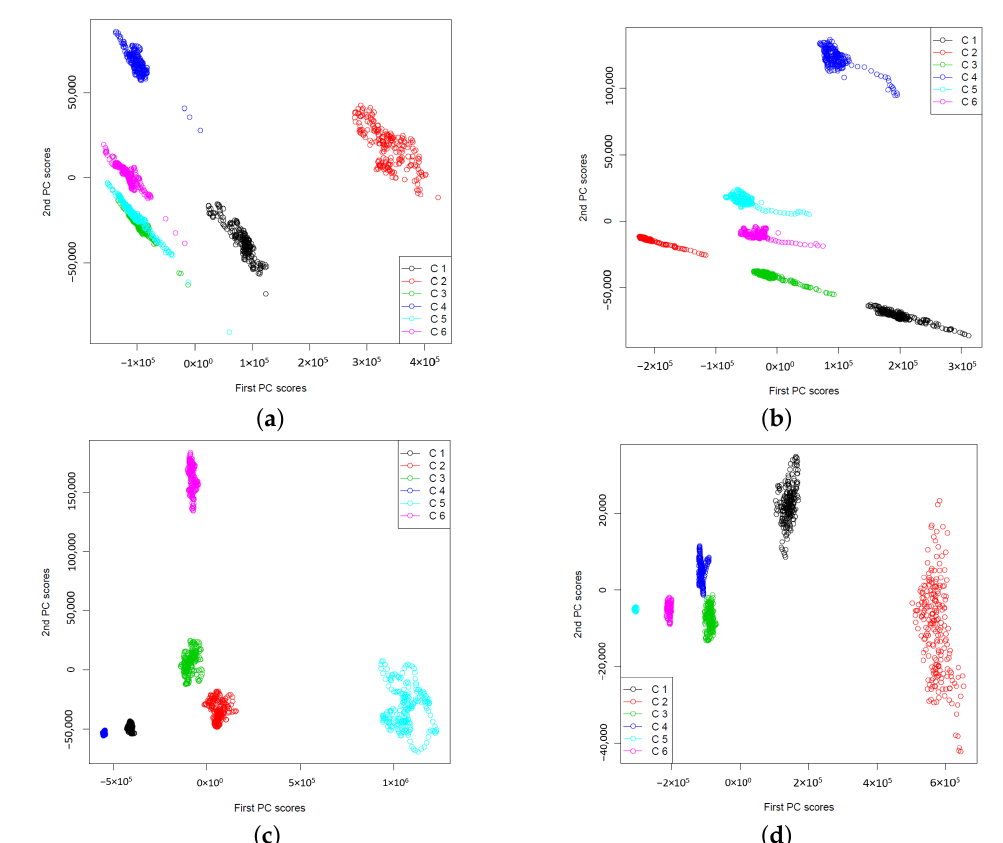
Figure 8. The plots of extracted two-dimensional features of DWT wavelet power spectra of patient specific interictal EEG signals. The maximum number of B-splines basis functions are used to smooth the sample wavelet power spectra, i.e., K = 10. ( a ) Patient 1, ( b ) Patient 3, ( c ) Patient 4, ( d ) Patient